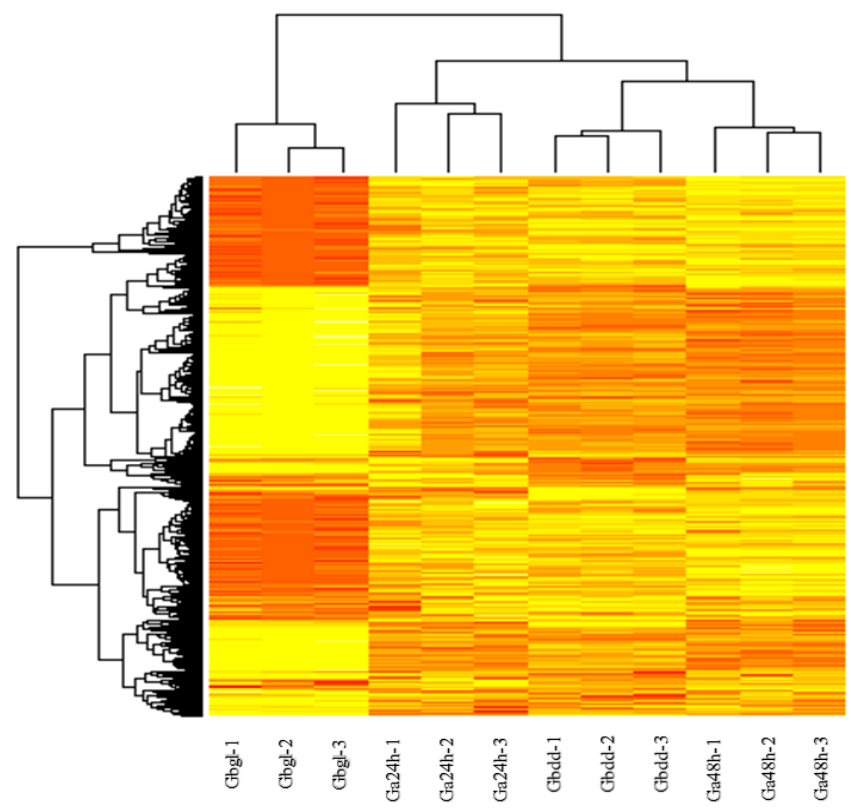
Figure 4. The expression pattern of DEGs from different biological replicates. A heat map represents the relative expression levels of genes based on fragment per kb per million of the mapped reads (FPKM) values using RNA sequencing (RNA-seq) data. Gbdd, Ga24h, Gbgl and Ga48h represent G. bickii glanded seedlings, G. arboreum glanded imbibed seeds, G. bickii glandless imbibed seeds and G. arboreum glanded seedlings, respectively.